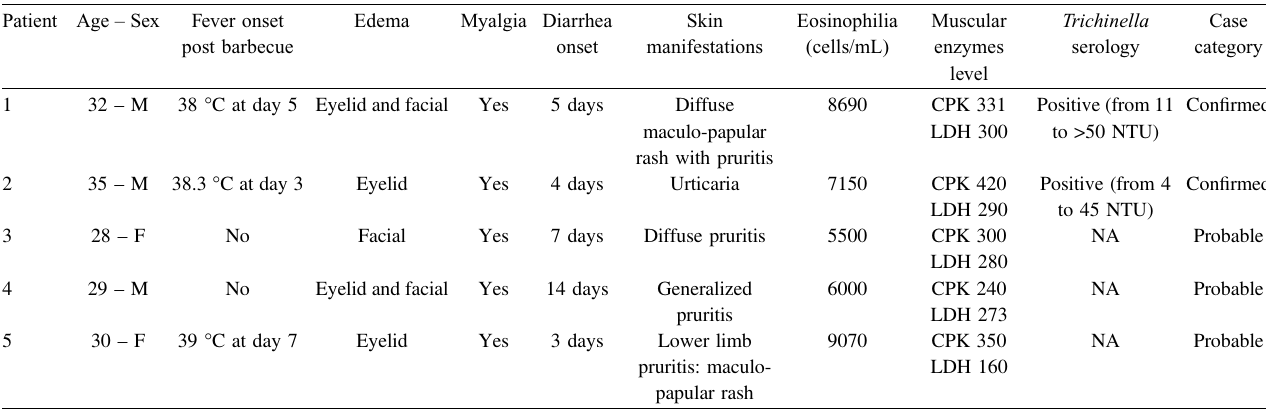
Table 1. Characteristics and symptoms described by